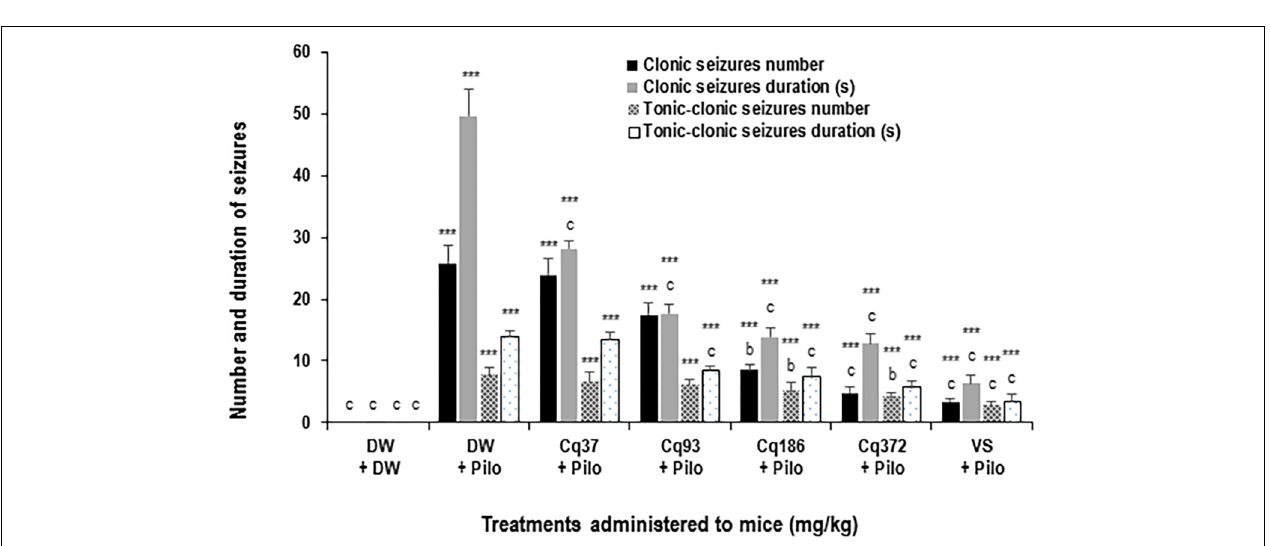
FIGURE 2 | Effects of C. quadrangularis extract on the number and duration of clonic and tonic–clonic seizures. Results are expressed as mean ± SEM for six animals. Data were analyzed by one-way ANOVA, followed by Tukey (HSD). ∗∗∗ p < 0.001, vs control animals (DW + DW group) receiving only distilled water; b p < 0.01 and c p < 0.001 vs disease control animals (DW + Pilo group) receiving distilled water and pilocarpine (360 mg/kg). DW, distilled water; Cq, Cissus quadrangularis ; Pilo, pilocarpine; SV, sodium valproate (300